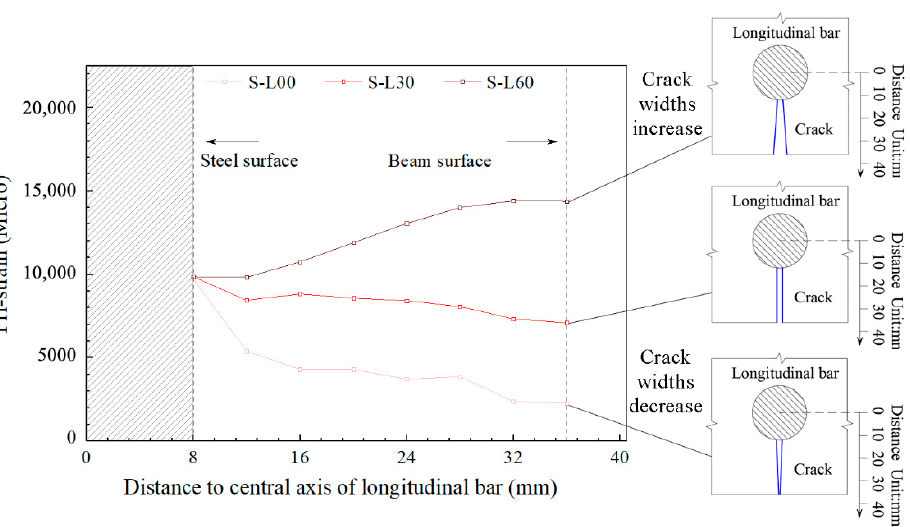
Figure 13. The principal strain along the crack path and the corresponding shape of the crack.